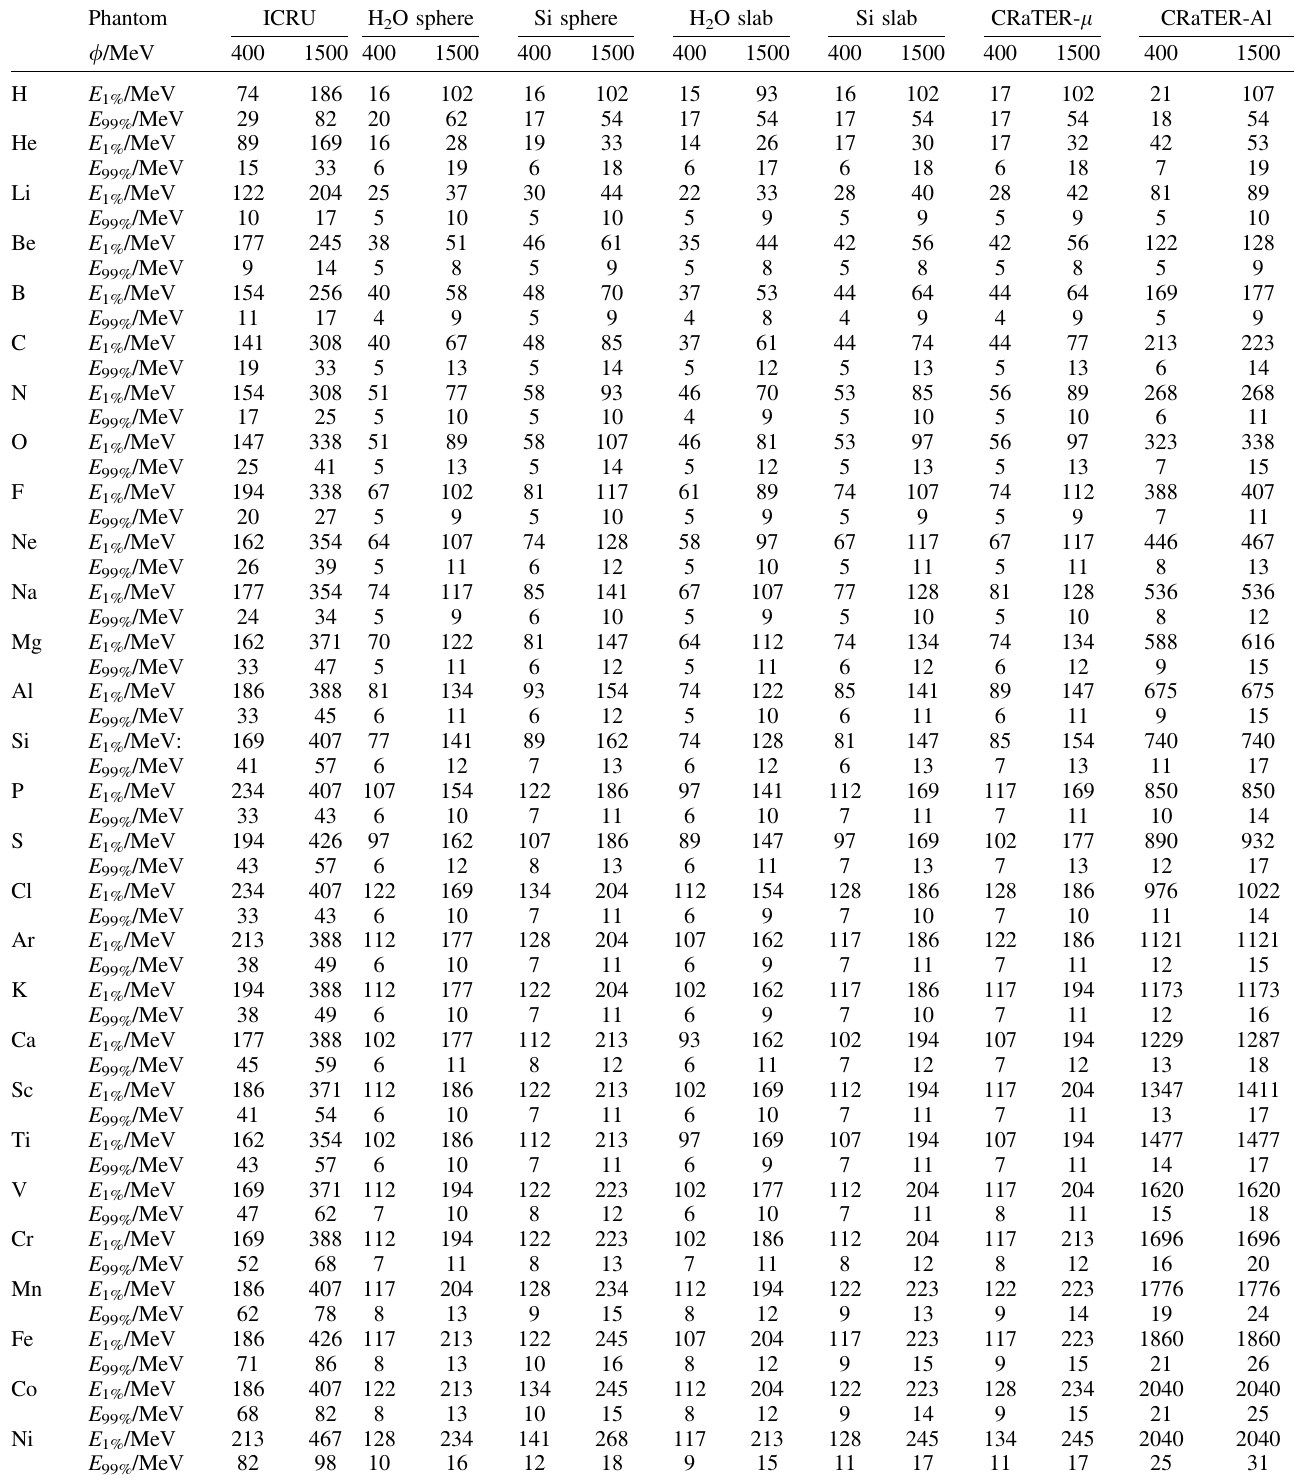
Table A1. GCR spectrum parameters specify the energy range responsible for 98% of absorbed dose rate in each phantom. For each GCR species, as indicated in the fi rst column, the energy range is speci fi ed for solar minimum ( / = 400 MV) and solar maximum ( / = 1500 MV). The CRaTER-Al column represents the microdosimeter with 5 mm shielding. Note that E 1% is in MeV, while E 99% is in GeV. The E 99% energies have been up-rounded and the E 1% have been truncated. To cover both solar minimum and maximum, the simulator should use E 1% ( / = 400 MV) and E 99% ( / = 1500